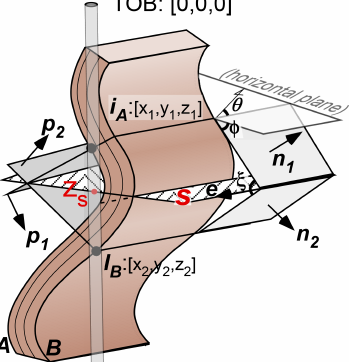
Figure 2. Schematic illustration of a cylindrical concentric fold and a borehole. TOB is the top of the borehole. A and B represent folded bedding planes. n and p are the normal vectors of the bedding plane and inflexion surface, respectively. e is the direction vector of fold axis. S is the axial plane. i A , I B , and Z s are the intersection points of the borehole and A, B, and the axial plane. θ , φ , and ξ indicate strike, dip, and interlimb angle,